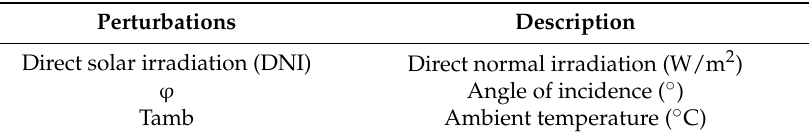
Table 2. Perturbations of the HTF-heating process.